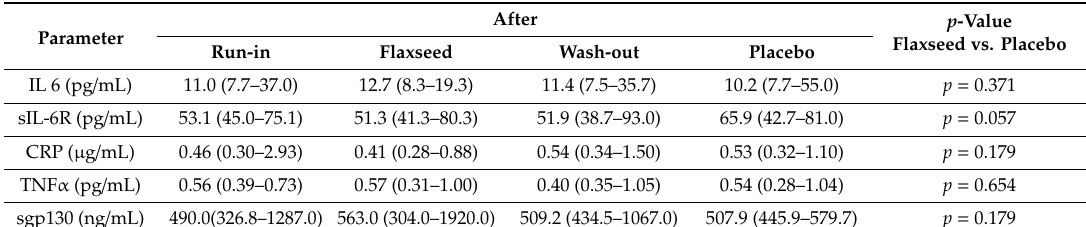
Table 3. Changes in inflammatory parameters throughout the study. The data are given as medians and ranges, n = 6.